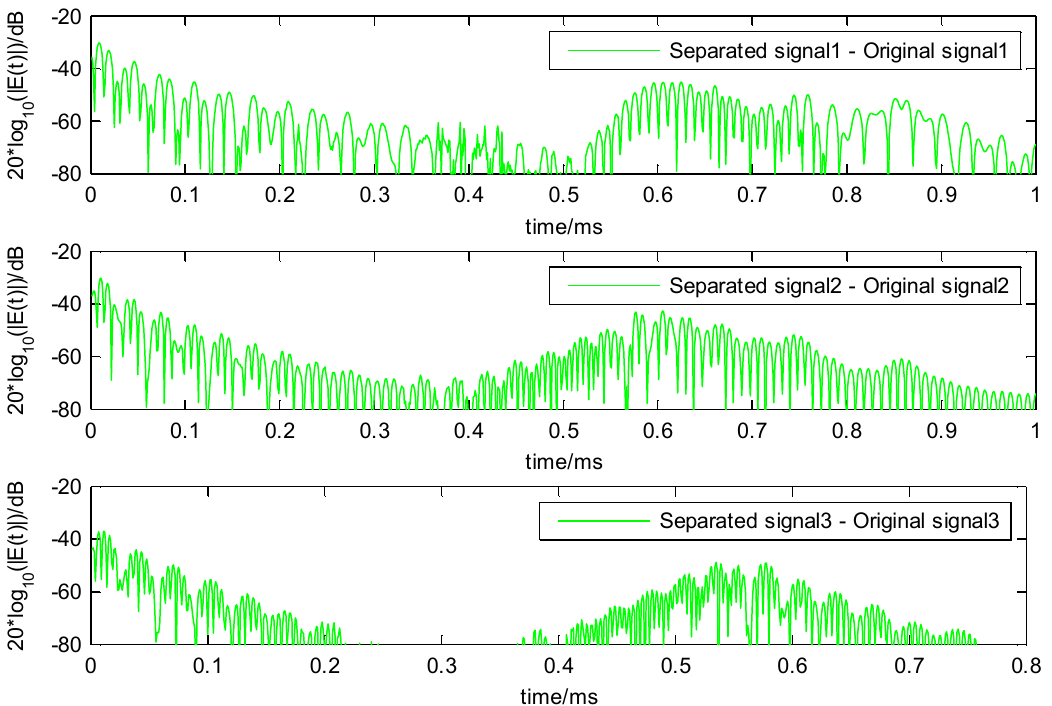
Figure 9. The difference value between separated signals and original signals calculated by 20*log_10(|E(t)|), the difference values are all less than 0.1 V.